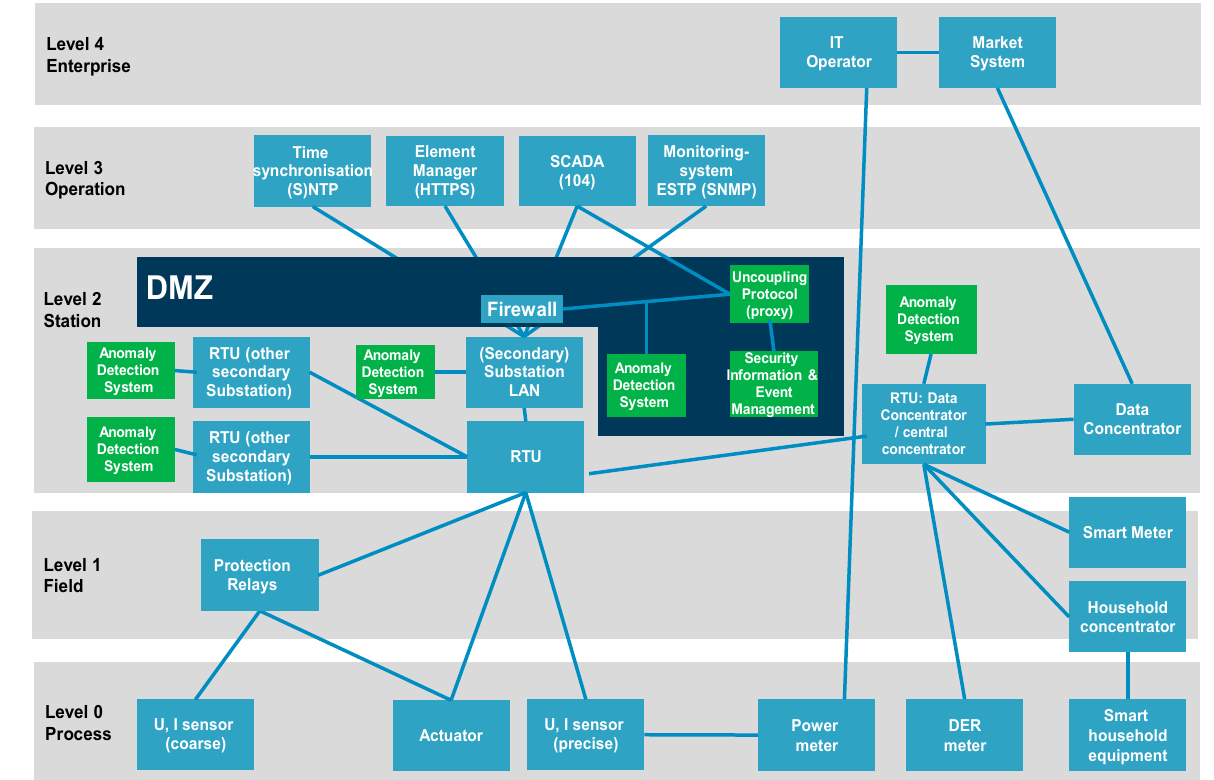
Figure 4. Future secure Smart Grid.